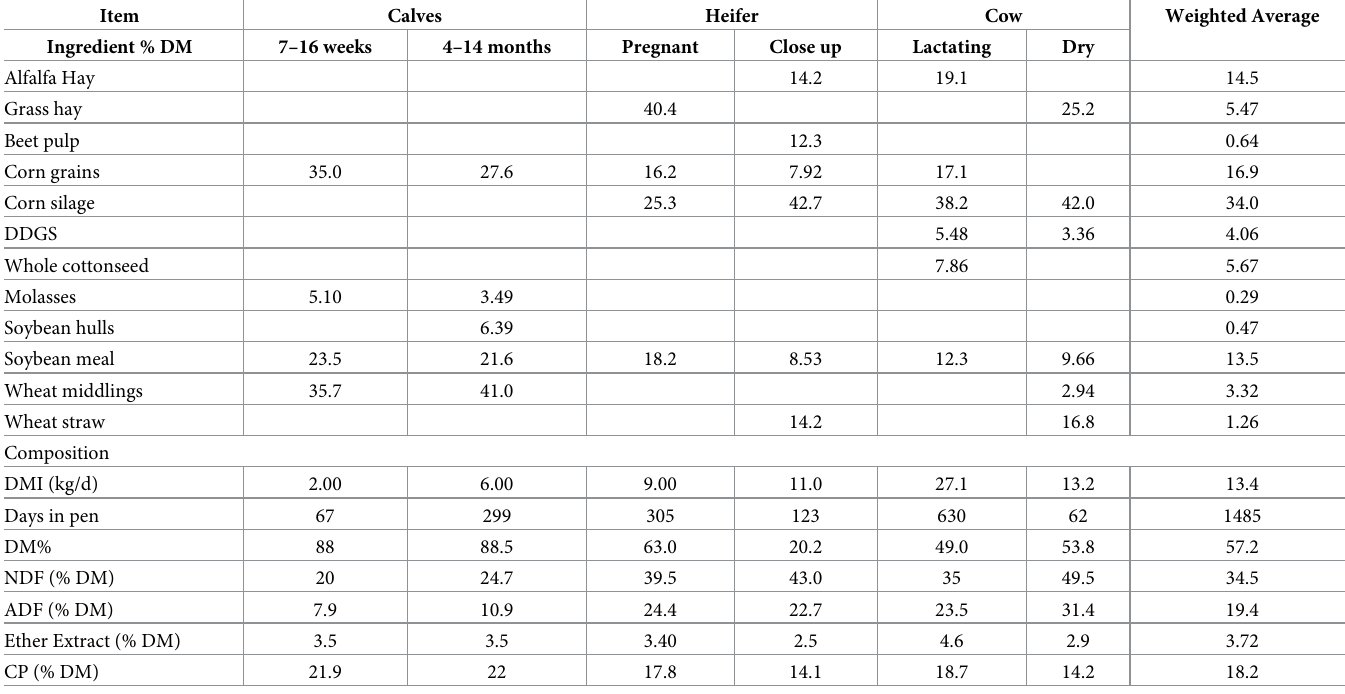
Table 1. Ingredient and nutrient composition of 1 kg of diet for calves, heifers, close-up heifers, lactating cows, and dry cows in the South Dakota dairy